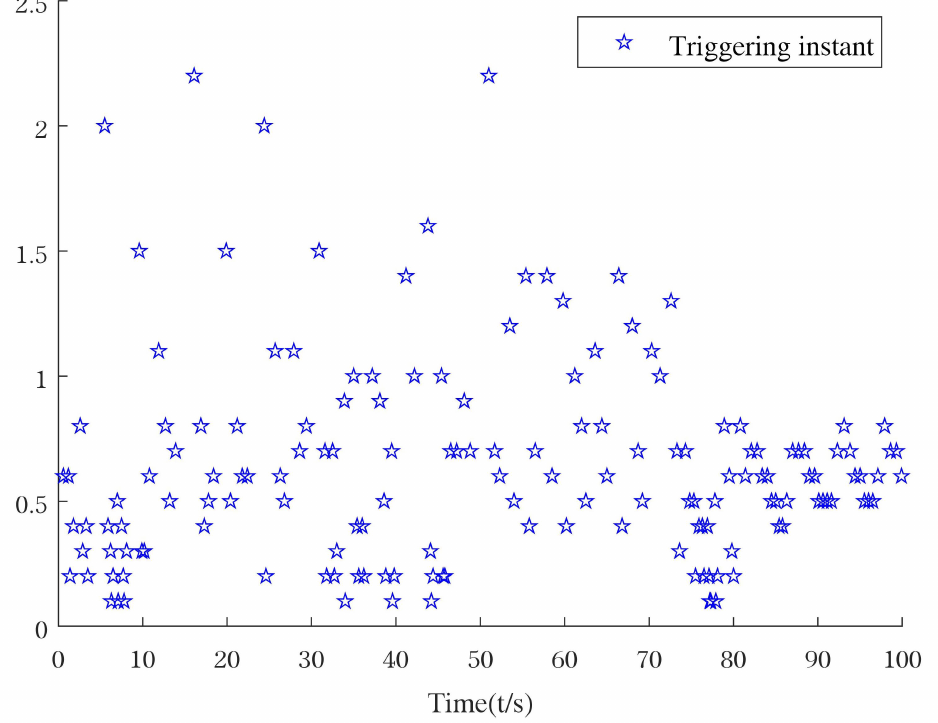
Figure 11. The event-triggered sampling